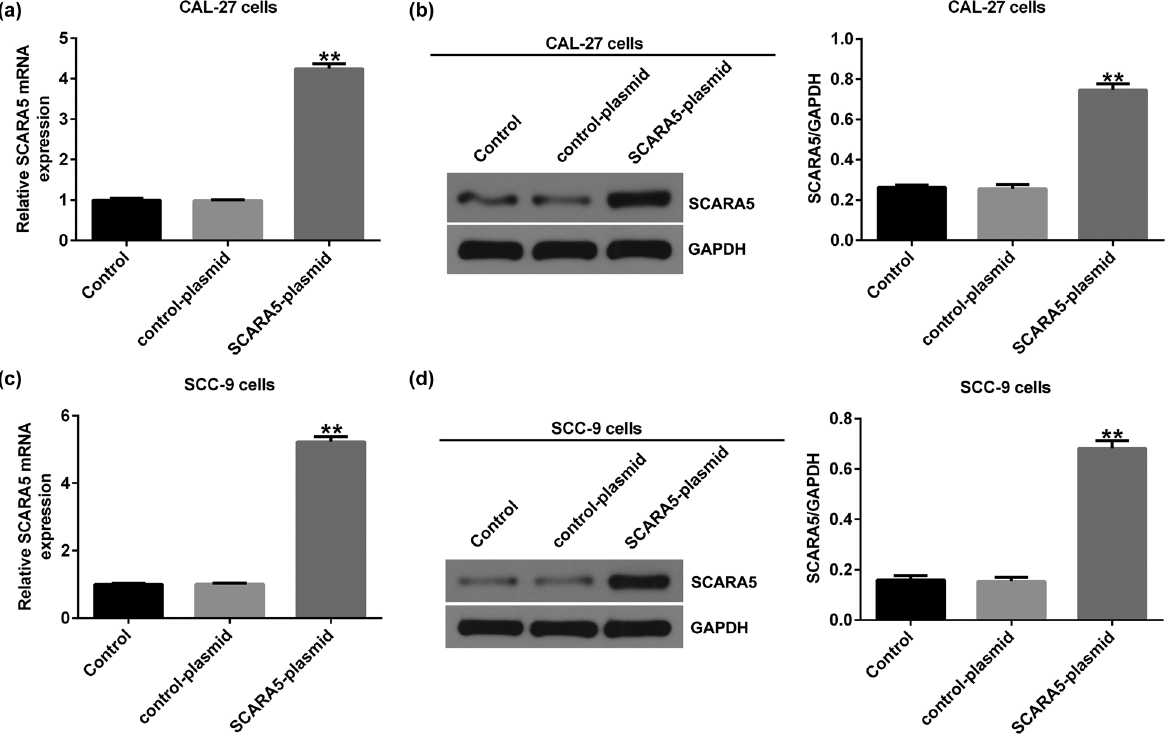
Figure 2: SCARA5 plasmid improved SCARA5 expression in OSCC cell lines. CAL - 27 cells were transfected with SCARA5 plasmid for 48 h. ( a ) qRT - PCR assay of SCARA5 gene expression in CAL - 27 cells. ( b ) Western blot assay determined the SCARA5 protein expression in CAL - 27 cells, and SCARA5/GAPDH was calculated. SCC - 9 cells were transfected with SCARA5 plasmid for 48 h. ( c ) qRT - PCR assay of SCARA5 expression at mRNA level in SCC - 9 cells. ( d ) Western blot assay of SCARA5 expression at protein level in SCC - 9 cells, and SCARA5/GAPDH ratio was presented. ** p < 0.01 vs control